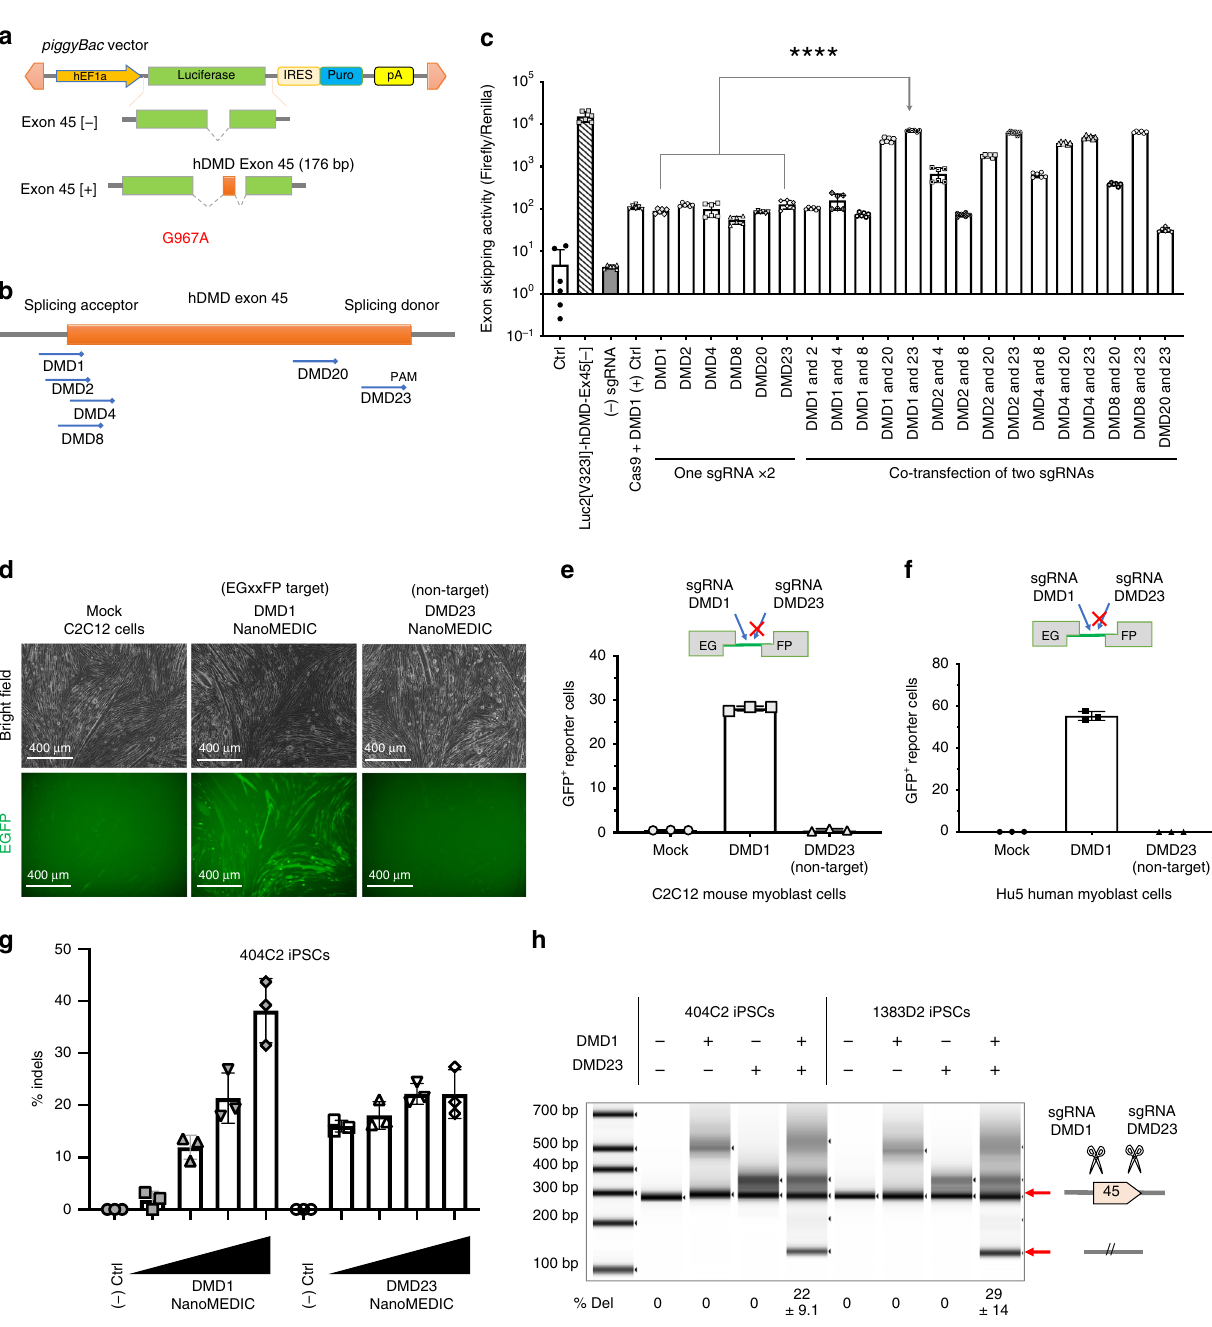
Fig. 3 sgRNA screening to target the splicing acceptor and splicing donor sites of dystrophin exon 45. a Schematic of piggyBac vector containing the luciferase reporter interrupted by human dystrophin exon 45 fl anked by intronic regions. b Schematic representation of the most active sgRNAs. c Luciferase exon skipping reporter activity in HEK293T cells comparing single sgRNA and dual sgRNAs transfected together with SpCas9 plasmid. Exon skipping activity: mean±S.D. from two experiments performed in technical triplicates. ****, P <0.0001 by one-way ANOVA. d , e C2C12 EGxxFP cells were differentiated into mature myoblasts and inoculated with NanoMEDIC targeting either the SA or SD site of exon 45. Only the DMD1-targeting sequence is contained in the reporter, not the DMD23-targeting sequence, which is indicated with an X. d Bright fi eld and GFP images that took 4 days after inoculation. e SSA-GFP + expression analysis by fl ow cytometry. The results are depicted in the bar graph. Only the DMD1-targeting sequence is contained in the reporter, not the DMD23-targeting sequence, which is indicated with an X. Percent indels: mean±S.D. from technical triplicates. f Hu5 EGxxFP human myoblasts were inoculated with NanoMEDIC containing RGR-DMD1 or RGR-DMD23.. Only the DMD1-targeting sequence is contained in the reporter, not the DMD23- targeting sequence, which is indicated with an X. Percent indels: mean±S.D. from technical triplicates. g 404C2 iPSCs were inoculated with increasing concentrations of NanoMEDIC containing RGR-DMD1 or RGR-DMD23. T7E1 analysis was performed to measure the indel percentage, which increased in a dose-dependent manner with increasing amounts of NanoMEDIC (1ng, 3ng, 10ng, and 30ng of active RNP complex). Cleavage products are indicated by the red arrows. Percent indels: mean±S.D. from technical triplicates. h Multiplexing NanoMEDIC produced with RGR-DMD1 and RGR-DMD23, respectively, resulted in dystrophin exon 45 deletion, measured by PCR ampli fi cation of genomic DNA of iPSCs from two healthy donors. iPSCs were treated with either RGR-DMD1, RGR-DMD23, or RGR-DMD1 + DMD23 NanoMEDIC. PCR ampli fi cation of dystrophin exon 45 deleted genomic DNA is indicated with a red arrow. Percent of deletion: mean±S.D. from technical triplicates. Source data are provided as a Source Data fi